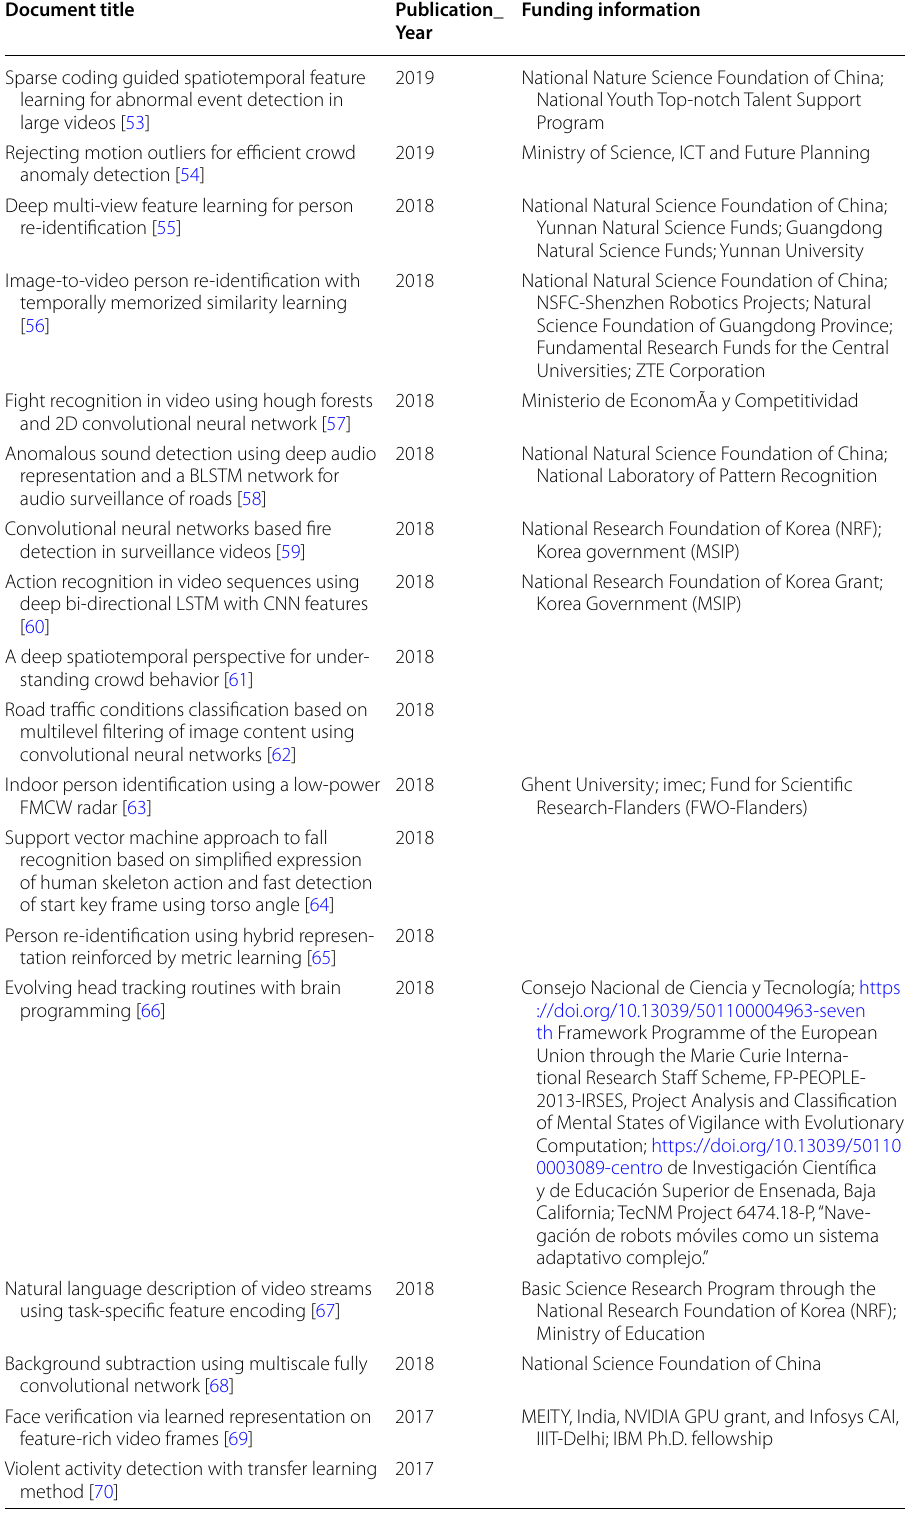
Table 5 Bibliographic summary of papers in IEEE